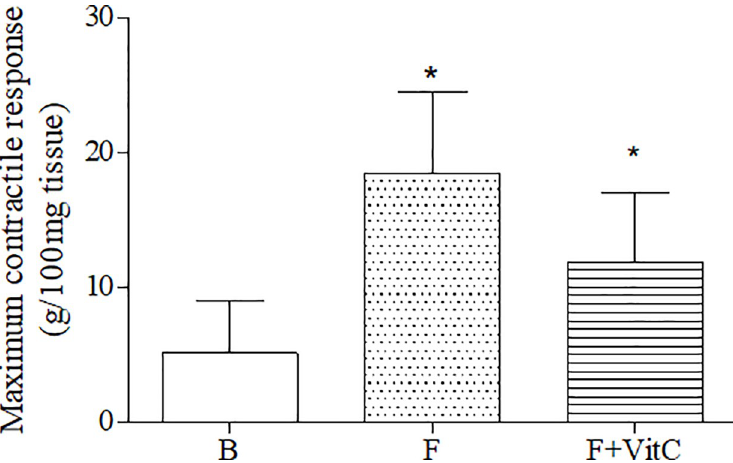
Fig 5. Vitamin C treatment did not alter the maximum contractile response to methacholine. Groups of mice were submitted to PQ or vehicle injection and after 7 days the animals were treated with vitamin C or vehicle daily until day 14th.Twenty-four hours after the last treatment the tracheal responsiveness was evaluate. Data represent the mean ± SEM of 6 animals. � P < 0.05 in relation to B group.